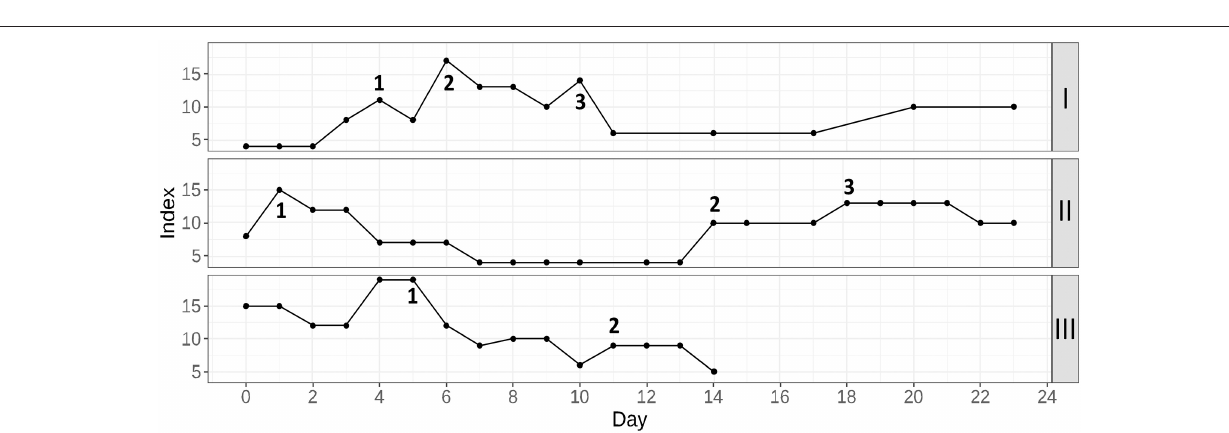
FIGURE 6 | Three examples of the proposed prognostic score application in routine clinical practice. Patient I: 1, start of anticytokine + antibacterial therapy; 2, plasma exchange session; 3, non-invasive ventilation in the general observation unit; Patient II: 1, the moment of the beginning of glucocorticosteroid therapy; 2, discovery of the hematoma; 3, a discontinuation of anticoagulant therapy; Patient III: 1, start of anticytokine + antibacterial therapy; 2, start of additional antimycotic